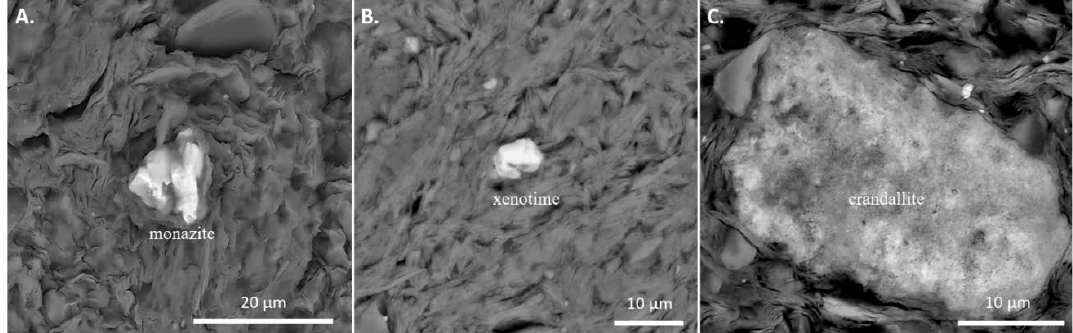
Figure 2. REE-bearing minerals observed and identified in the Central Appalachian Basin underclays including monazite (A), xenotime (B), and crandallite (C).